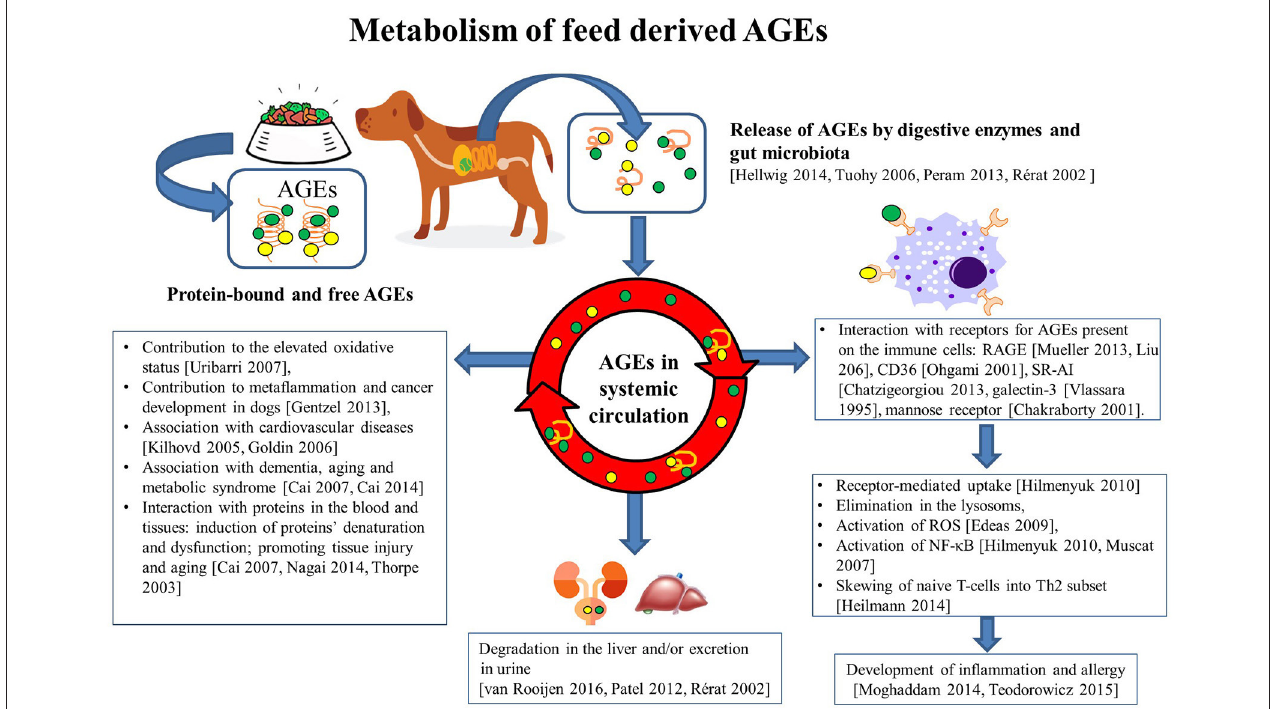
FIGURE 1 | Metabolism of feed derived AGEs. Upon processing of animal feeds, protein-bound and free AGEs appear in the feed. These AGEs can be released in the intestinal tract as a consequence of the interaction with digestive enzymes and also intestinal microbiota. When absorbed, these AGE mat interact with the mucosal immune system by binding to several receptors (RAGE, CD36, Galectin-3, SR-A1, mannose receptor) expressed on immune cells. In particular, innate immune cells may subsequently become activated (through activation of the NF-kB pathway) and produce reactive oxygen species (ROS), and cytokines. Together these activities may skew the resulting T-cell activation and contribute to the development of increased oxidative stress, metaflammation and tissue damage, cancer cardiovascular diseases, metabolic syndrome and type 2 diabetes, and dementia and premature aging. The uptake of AGE in the intestinal tract can also result in appearance in the systemic circulation here these compounds will be degraded in the liver and be excreted in the urine. Collectively, these activities of AGEs explain their effects on health, welfare, growth, and performance of the animal in ways very similar to those known from the human